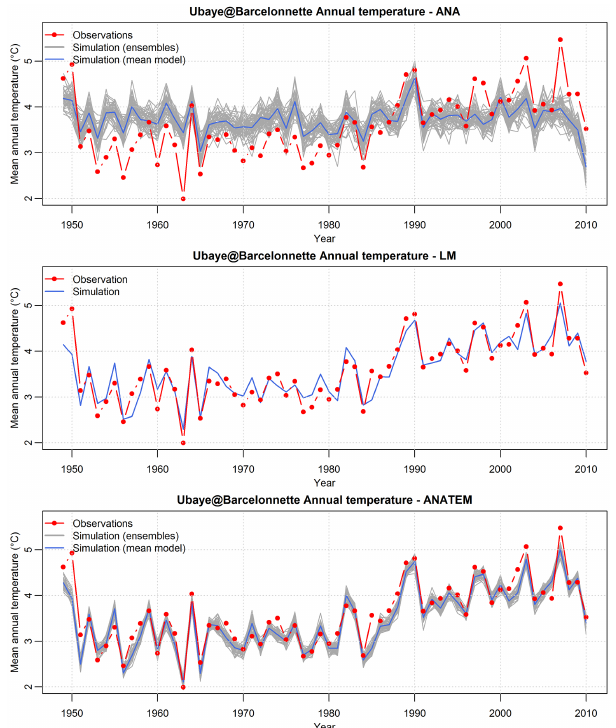
Figure 6. Annual time series of air temperature reconstructions for the Ubaye River at Barcelonnette watershed by the analogue (ANA), local (LM) and ANATEM